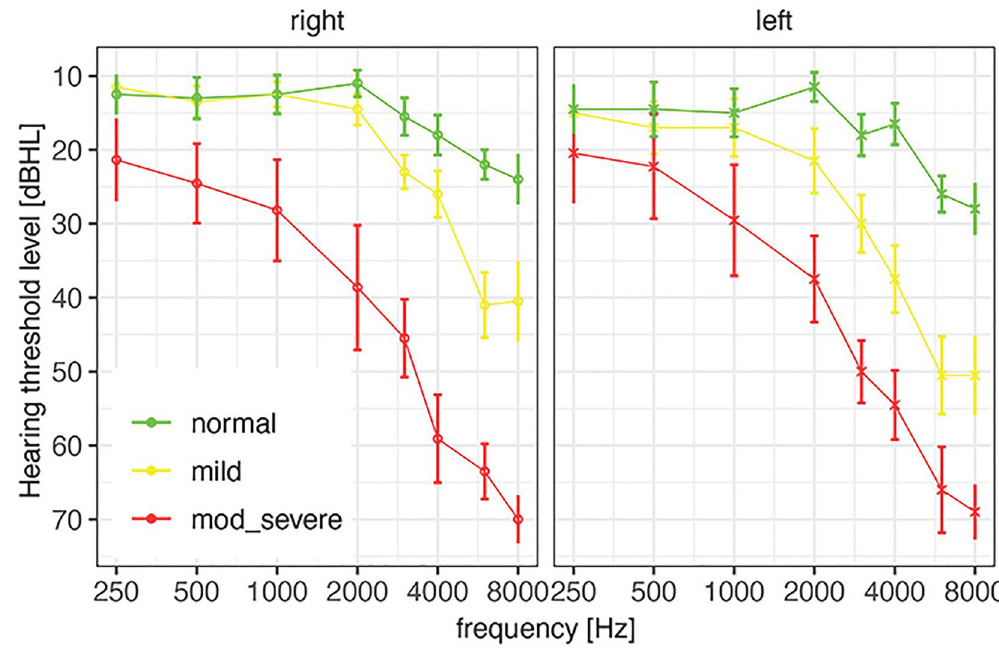
Figure 4. Average hearing thresholds per hearing loss category for the left and right